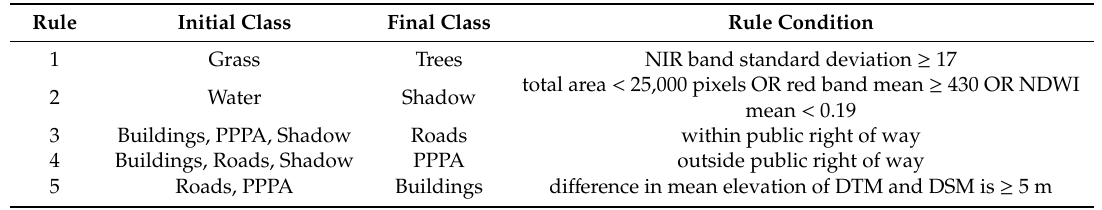
Table 2. Refining rules applied after Bayes